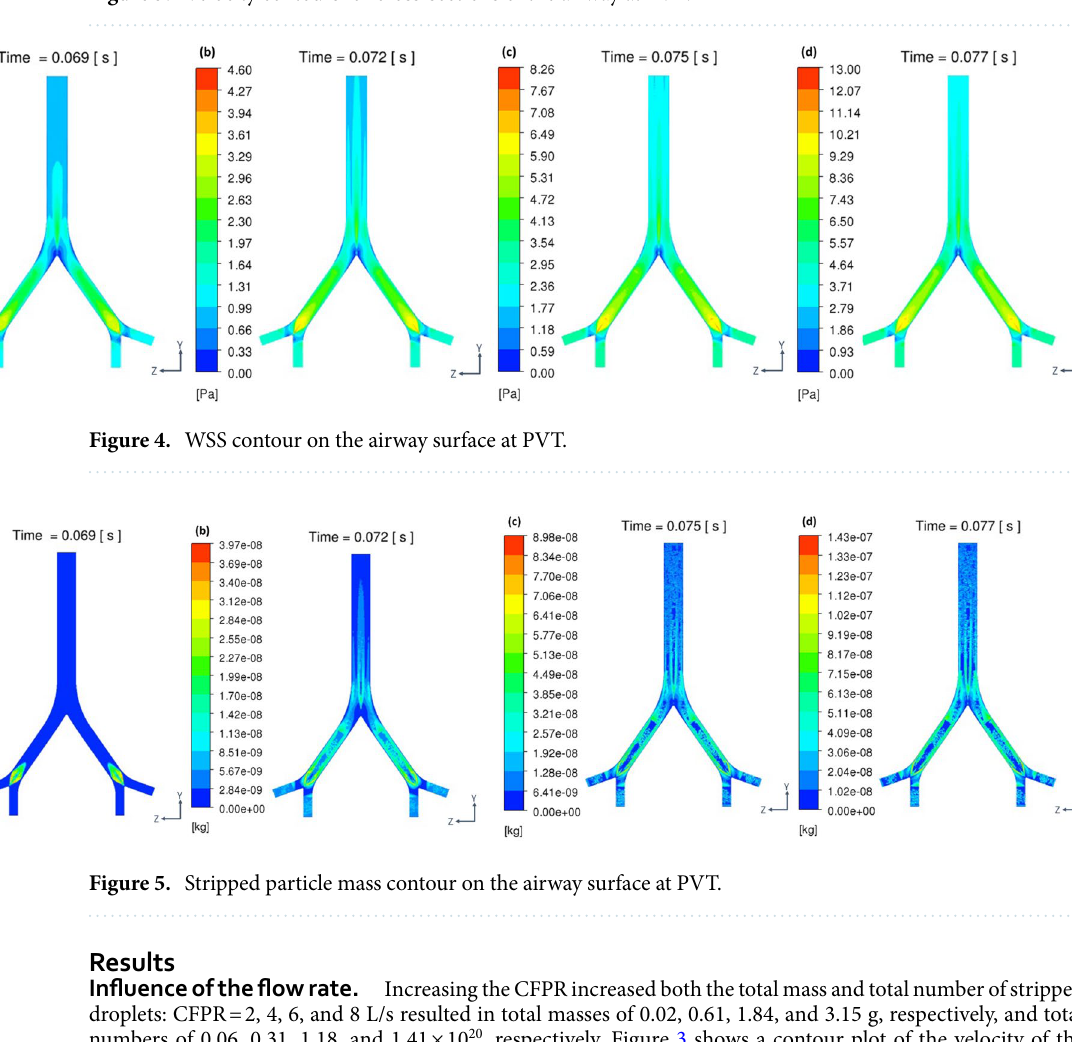
Figure 3. Velocity contours for cross-sections of the airway at PVT.